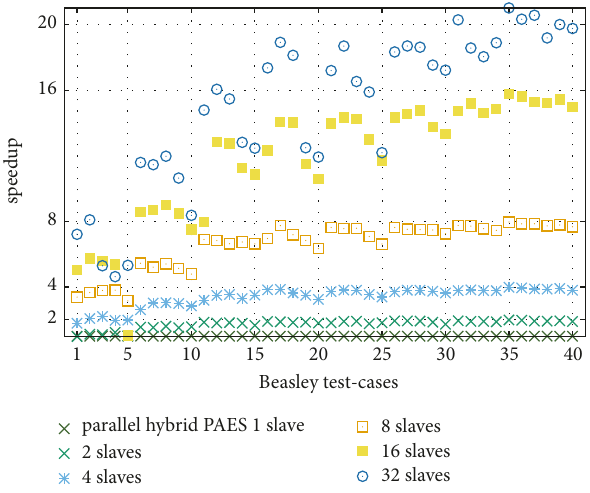
Figure 4: Speedups obtained with up to 32 slaves for hybrid PAES on the Beasley